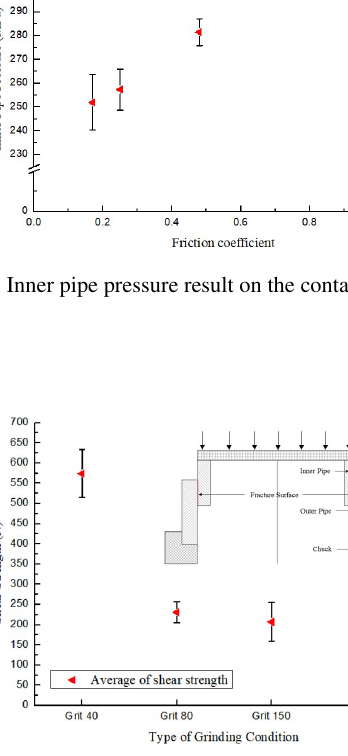
Figure 16. Relationship of total pressure and shear